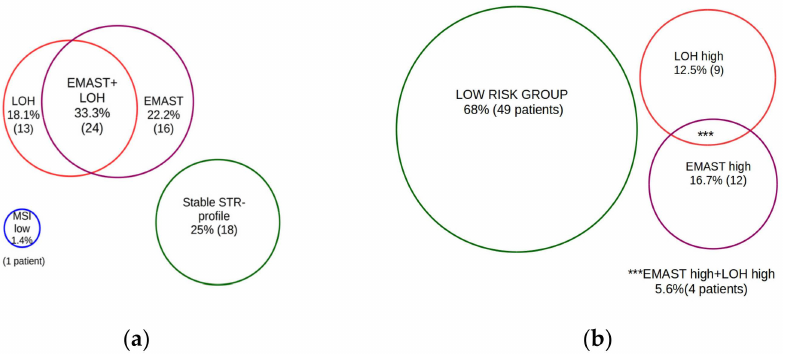
Figure 3. Venn diagram indicating the distribution of 72 PMBCL patients according to their LOH, MSI and EMAST status. ( a ) distribution according to the presence, absence, or combination of lesions ( b ) distribution of “high” or “low” occurrence of the lesions.